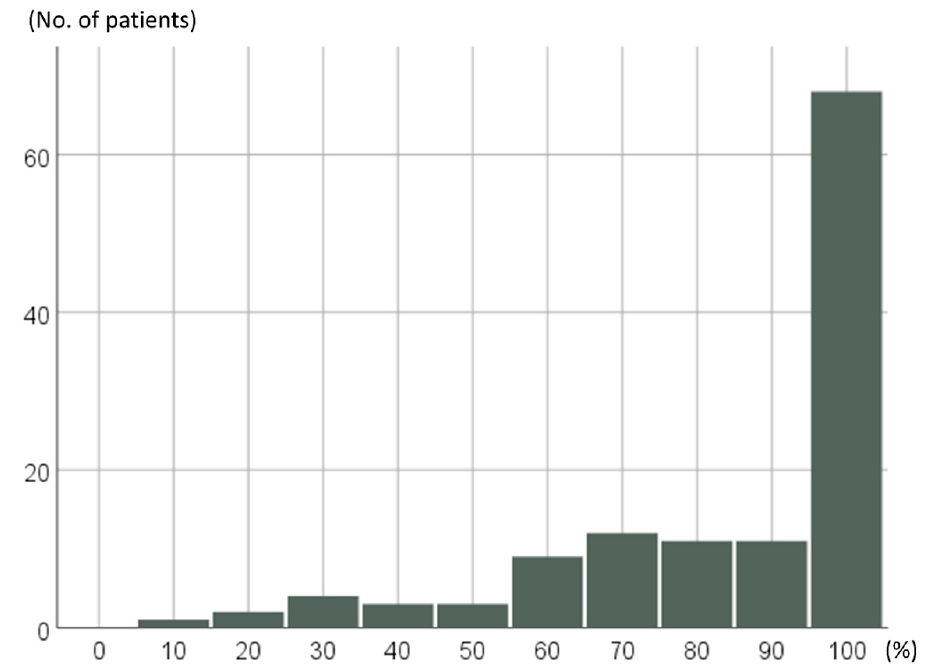
Figure 2. Distributions of relative dose intensity (RDI) separated by 10% in the 124 pazopanib-treated STS patients.